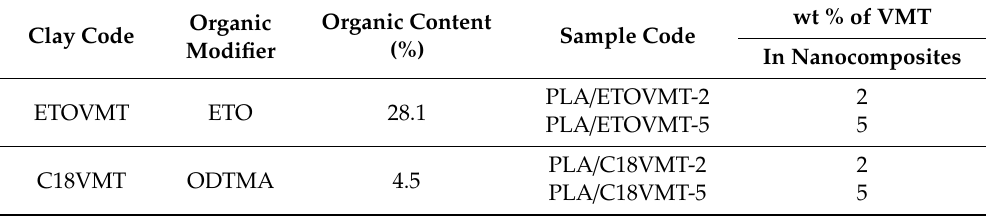
Table 1. Characteristics of clays and nanocomposites, designation, and clay